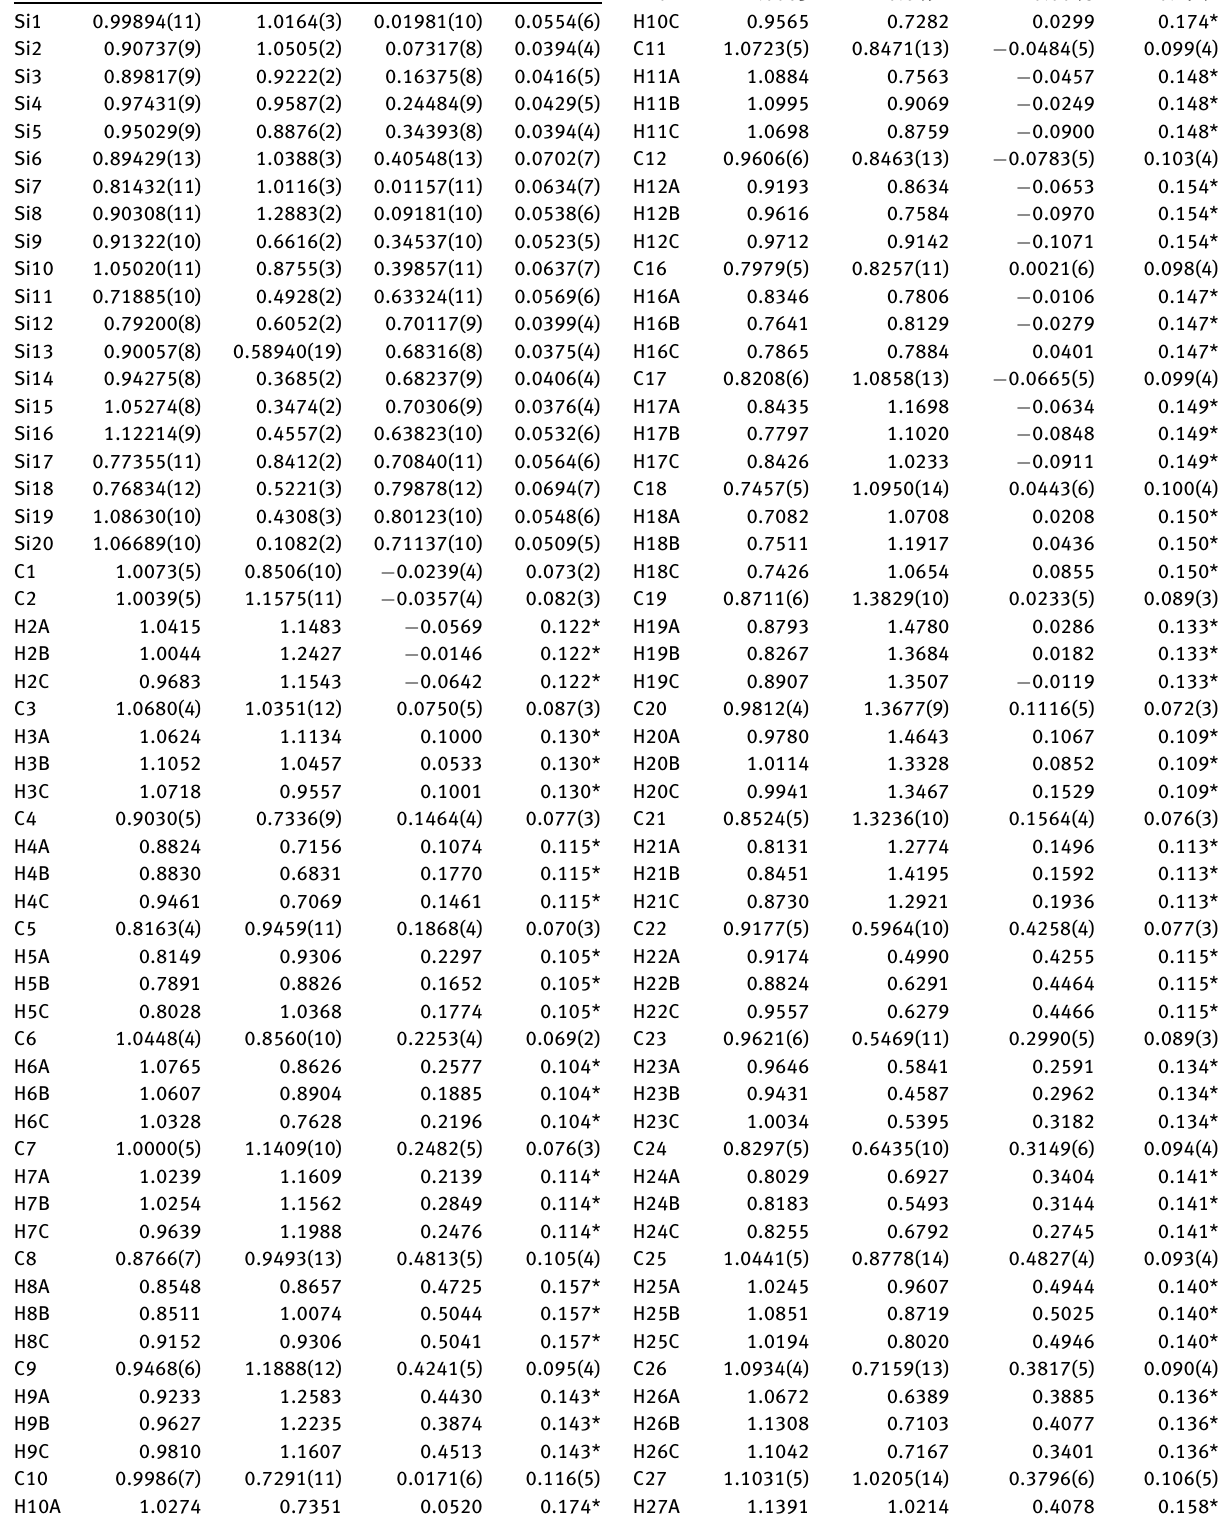
Table 2: Fractional atomic coordinates and isotropic or equivalent isotropic displacement parameters (Å 2